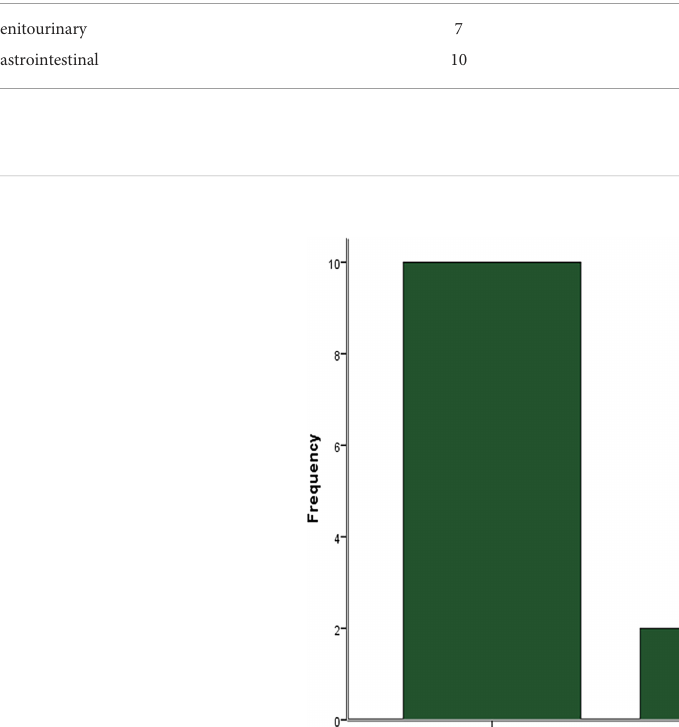
TABLE 3 Acute toxicity after EBRT. Acute <6 monthsCTCAE v5.0